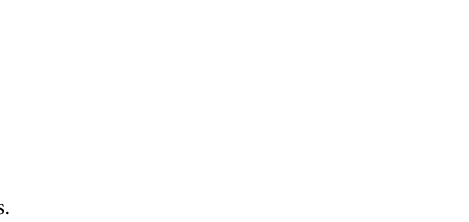
Figure 6. Electrochemical analysis: ( a ) OCP, ( b ) PDP, (c) and ( d ) EIS results, and ( e ) equivalent electric circuit.